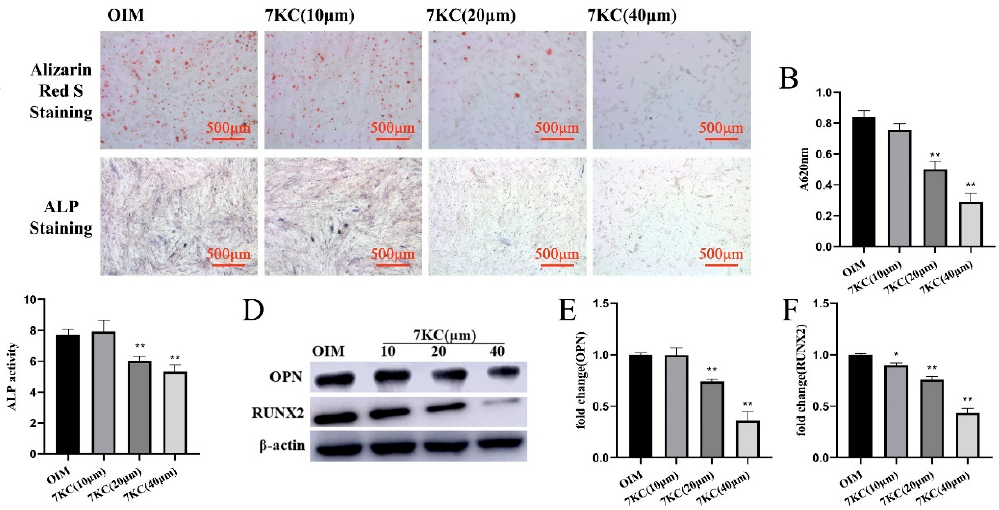
Figure 2. 7KC inhibited the osteogenic differentiation of MC3T3-E1 cells. MC3T3-E1 cells were treated with 7KC (0, 10, 20, or 40 μ M). ( A – C ) ALP activity detection and the mineral assays were performed (×50 magnification); ALP activity detection and quantitative analysis of the mineralized area. The protein expressions of OPN ( D , E ) and RUNX2 ( D , F ) were analyzed by Western blot. Data were analyzed and compared with the OIM group. * p < 0.05; ** p < 0.01. OIM, osteogenic induction medium.